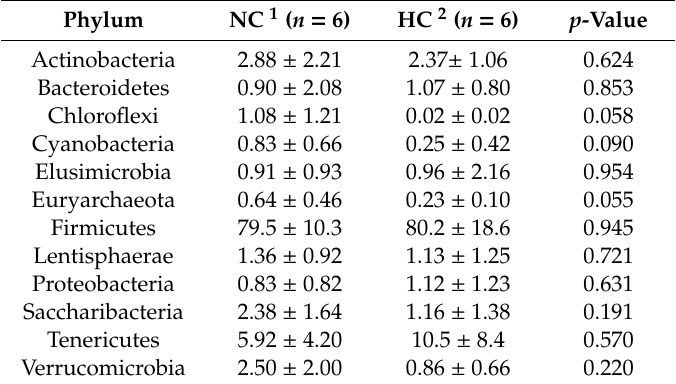
Table 3. Phylum-level composition (%) of the ileal bacterial community of twelve goats fed normal- concentrate (NC) and high-concentrate (HC) diets.